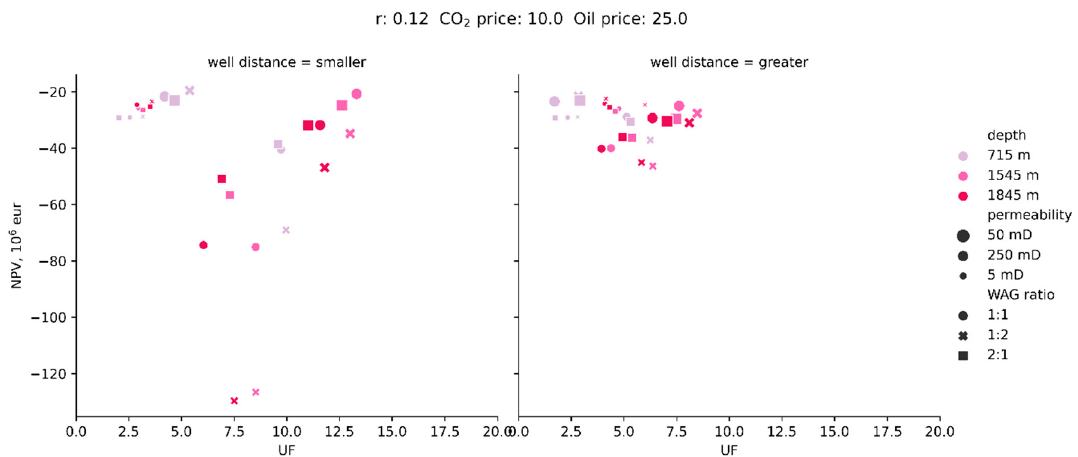
Figure 17. NPV versus UF for the pessimistic scenario at the end of EOR with 20 € /MWh electricity price.